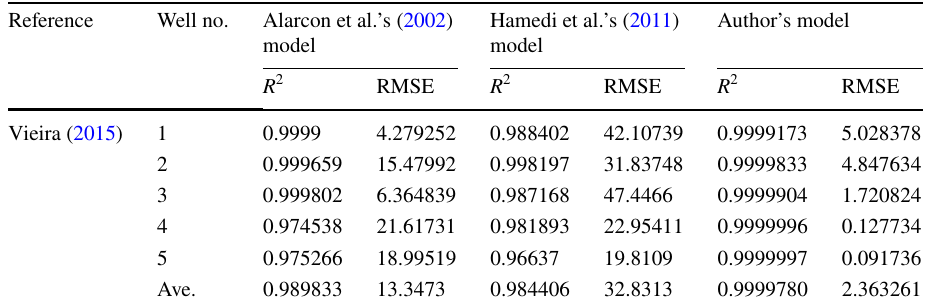
Table 3 Results of author’s model, ANN method, Hamedi et al.’s (2011) model and Alarcon et al.’s (2002) model for fitting operational data from Tavakoli et al.